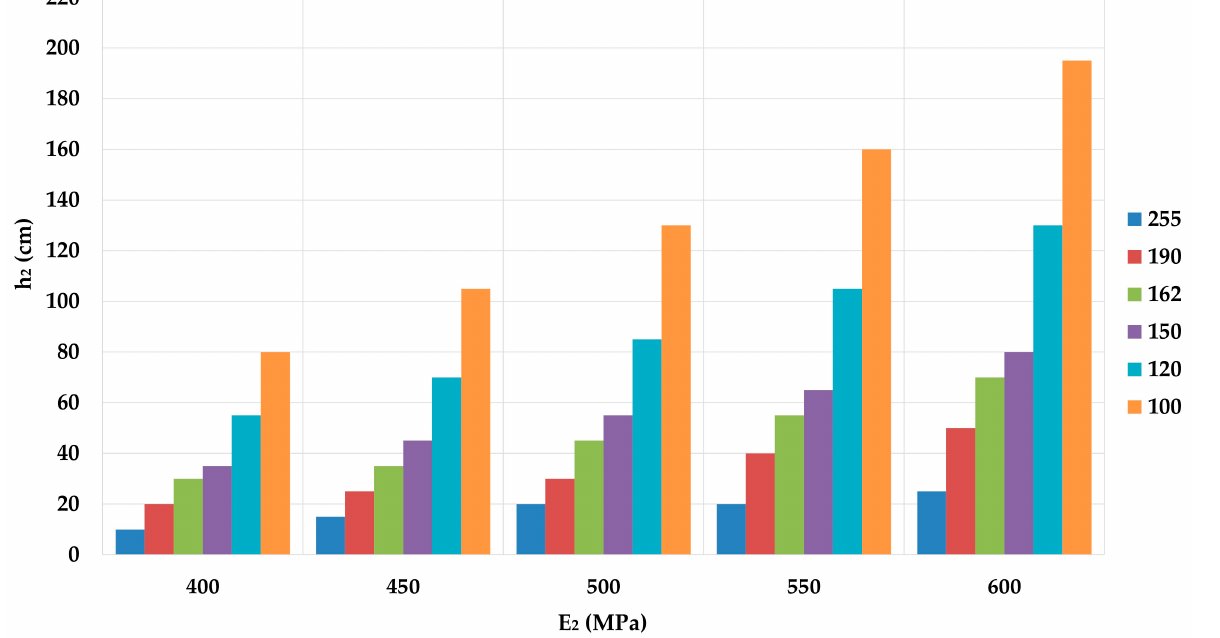
Figure 8. Values of thickness h 2 (cm), based on E 2 values, per M R –CBR correlation.